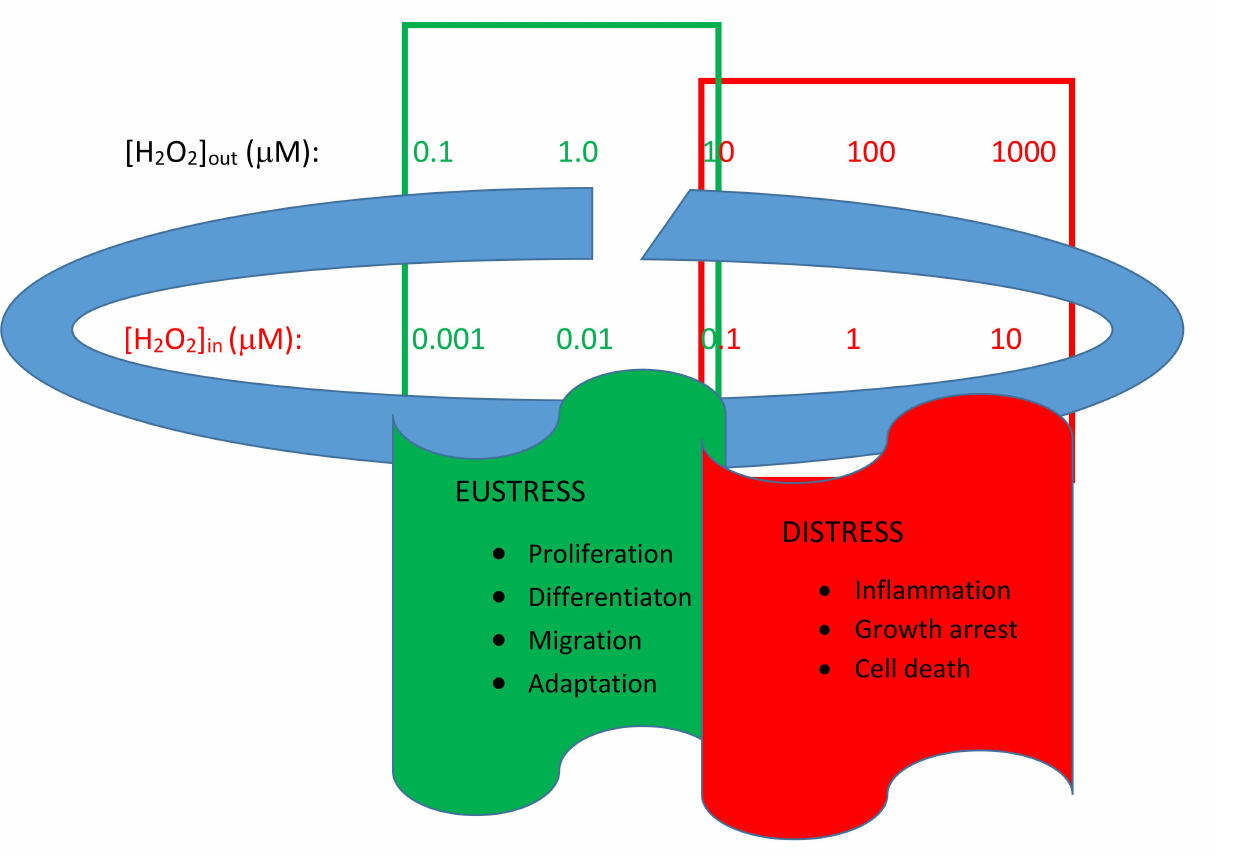
Figure 1. Homeodynamic space. The interpretative model of the regulation of the cellular redox state is based on the existence of a physiological range called “homeodynamic space”. The relative concentration of H 2 O 2 could determine situations of eustress and distress. In the situation referred to as eustress, the intracellular H 2 O 2 concentration is estimated to be 1–10 nM, while the cytosolic concentration is even lower (around 100 pM). The mitochondrial matrix has a peroxide concentration slightly higher than the cytosolic one (up to 20 nM), thus ensuring a gradient between the organelle and the cytoplasm. In the extracellular space, the H 2 O 2 concentration is between 1 and 5 µ M, thus ensuring a gradient of approximately 500 times between the outside and inside of the cell